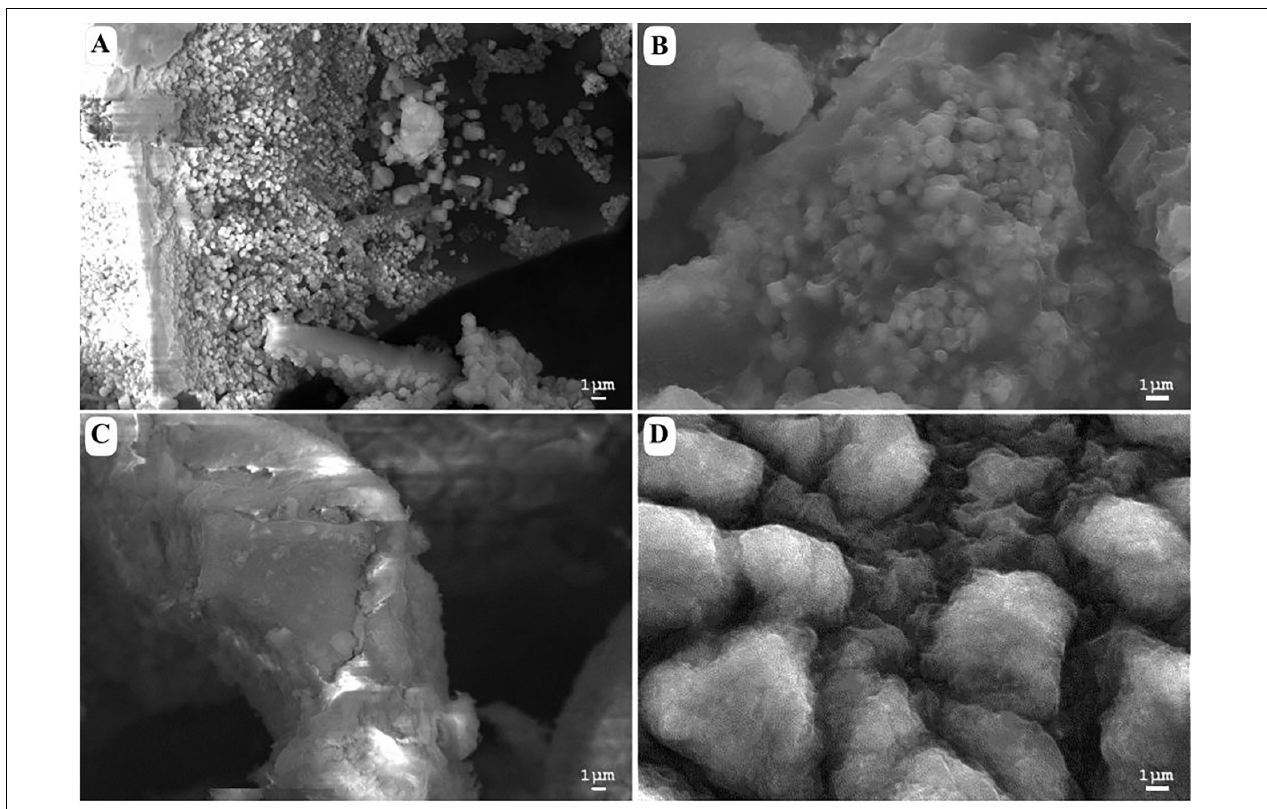
FIGURE 2 | Scanning electron microscopy images of (A) acid-biodegraded lignin, (B) alkaline-biodegraded lignin, (C) control of acid biodegradation, and (D) control of alkaline biodegradation. Scale of reference of 1 µ